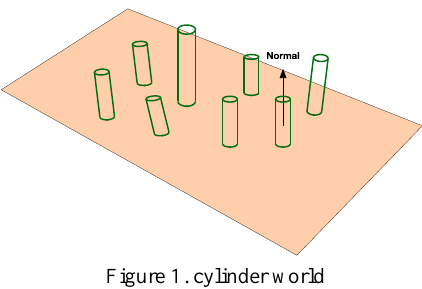
Figure 1. cylinder